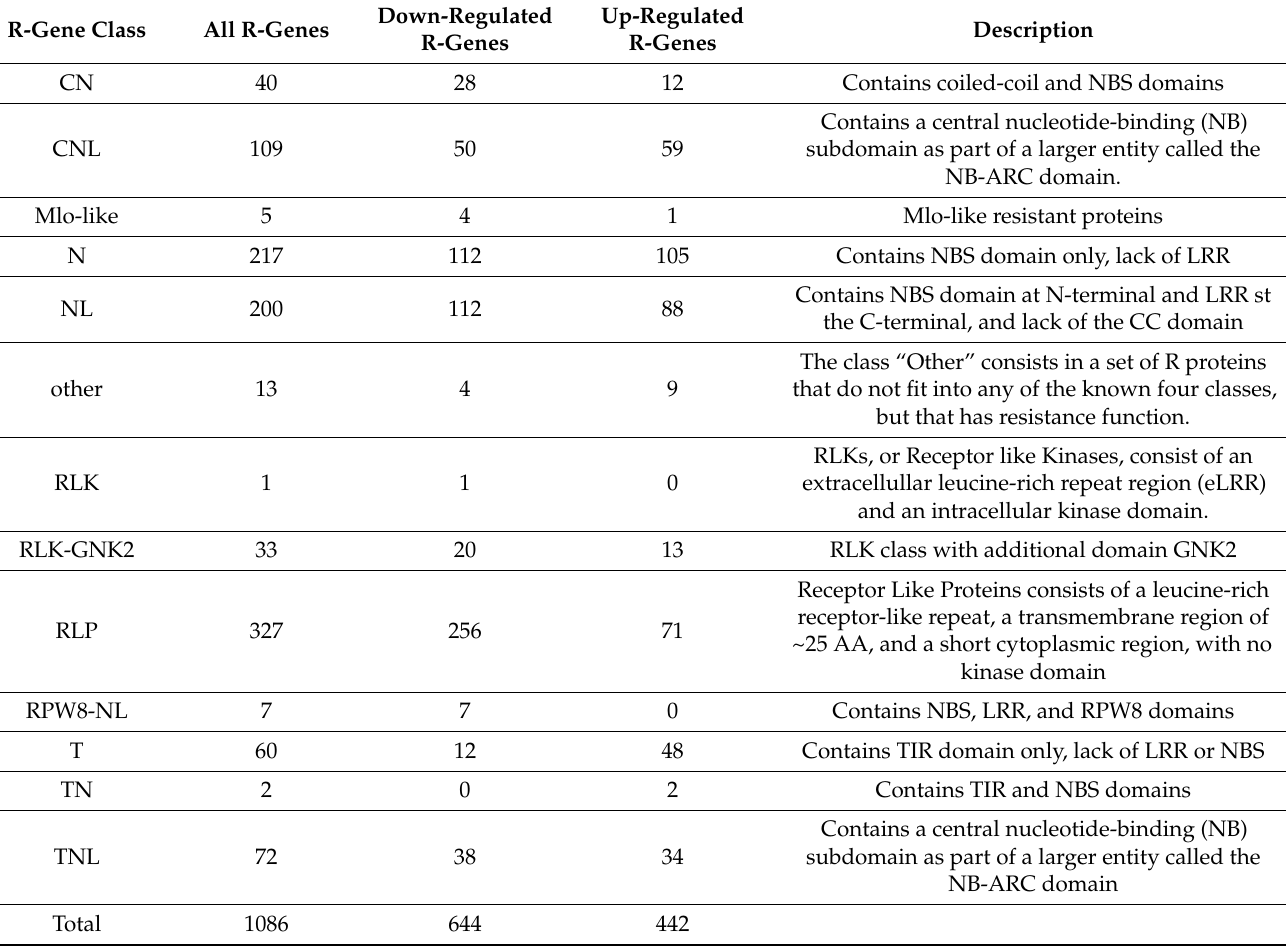
Table 1. Classification of up- and down-regulated R-genes among the DEGs in M. sinostellata